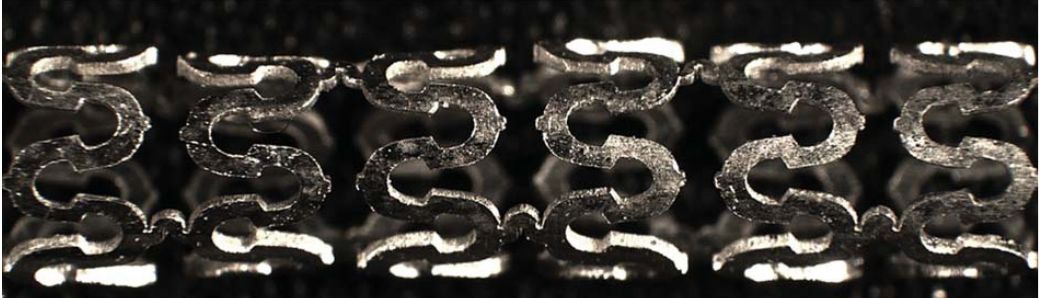
Figure 8: Optical microscopy image of the AZ31 after chemical etching.